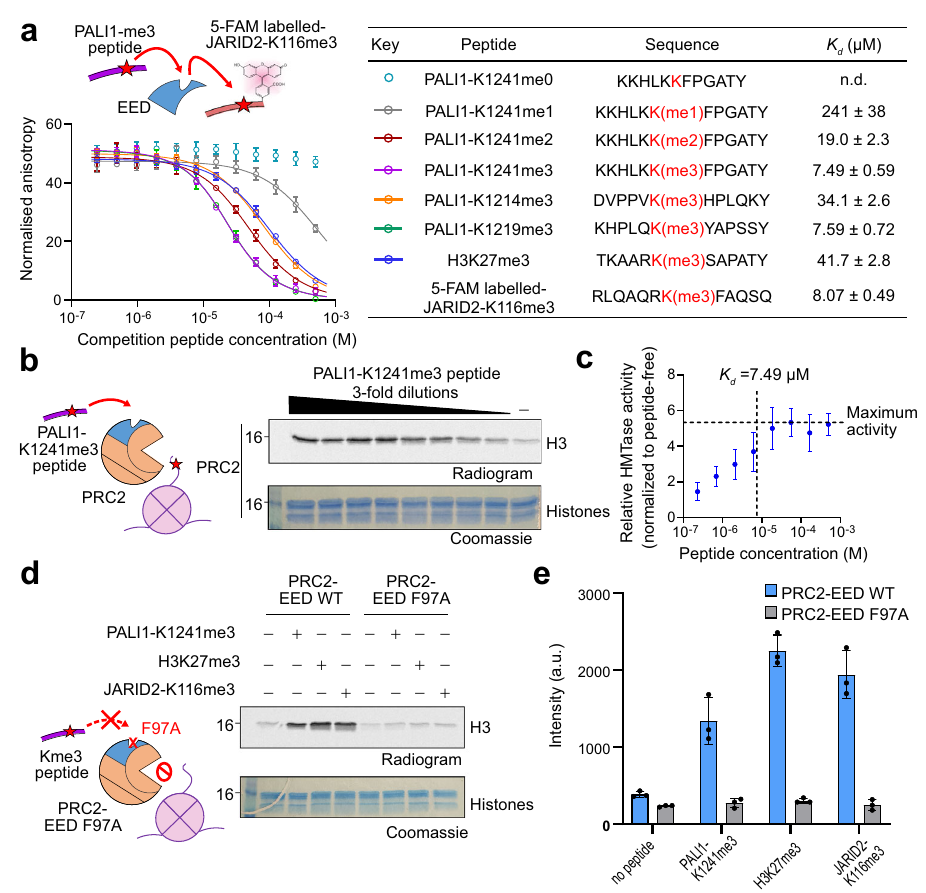
Fig. 3 PALI1-K1241me3 binds to the aromatic cage of EED to stimulate PRC2 activity. a Fluorescence anisotropy displacement titrations, where unlabelled peptides competed a 5-FAM labelled JARID2-K116me3 peptide (40 nM) for binding to EED (10 µ M). Each data points in the plot indicate the mean of the normalised anisotropy values and the error bars represent standard deviation over three independent replicates that were carried out on different days. Dissociation constants ( K d ) and 95% con fi dence bounds on the coef fi cient are indicated in the table. The sequence of the peptides indicated in the table, with the methyl-lysine in red. See Supplementary Fig. 3a for the binding curve of the 5-FAM labelled JARID2-K116me3 to EED. b HMTase assay performed using PRC2 in the presence or increased concentrtions of PALI1-K1241me3 peptides. c Data from b is presented, with the activity of the peptide- stimulated PRC2 is normalised to the activity of PRC2 in its basal state. Each data points indicate the mean of the relative HMTase activities from b quanti fi ed using densitometry, which was carried out on three independent replicates, and the error bars represent standard deviations. The maximum activity of PRC2 is represented by a horizontal line. The vertical dashed line represents the K d of PALI1-K1241me3 peptide and EED, as quanti fi ed in a . d HMTase assay performed using wild-type (WT) or cage-mutant PRC2 (EED F97A) in the presence or absence of stimulatory peptides, as indicated. e The bar plot represents the means of quanti fi cation from d using densitometry done on three independent replicates. Error bars represent standard deviation and the observed values indicated in dots. The numbers on the left side of the gels and radiograms in b , d represent the molecular weight marker in kDa. Uncropped gel images used to generate this fi gure are in Supplementary Fig. 3. Source data for this fi gure are provided as a Source Data fi tri-methyl-lysine peptide ( K d = 7.49 ± 0.59 µM) (Fig. 3a). In